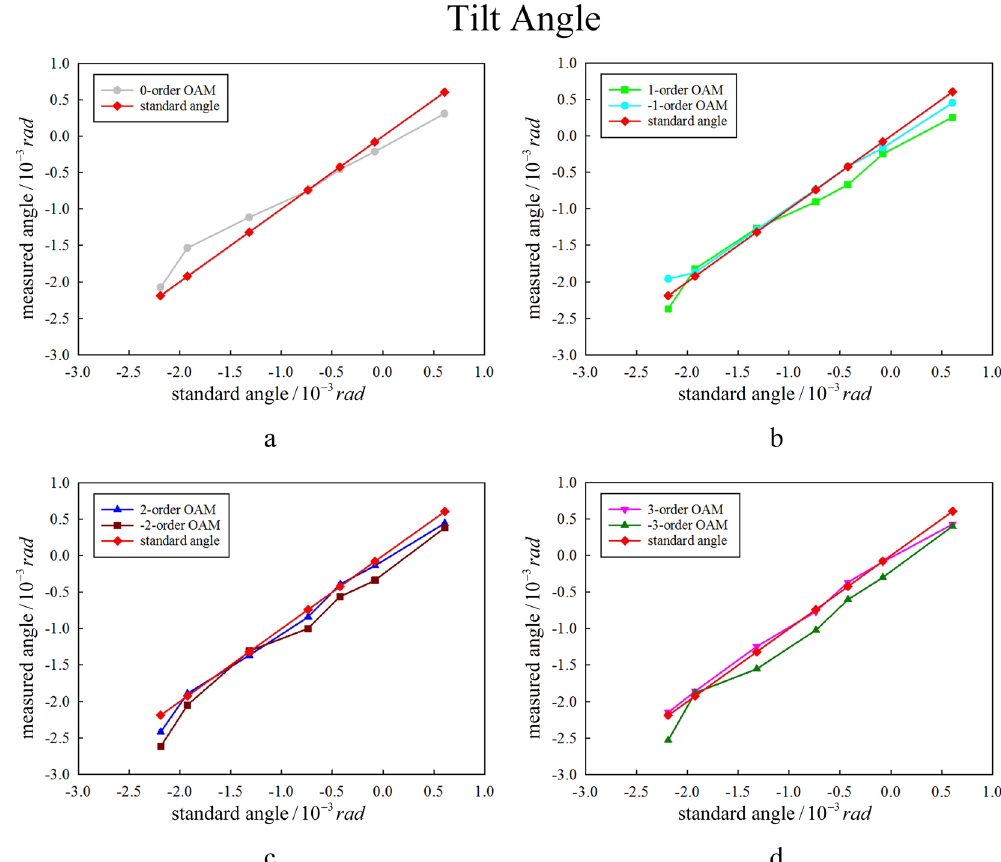
Figure 6. The measured tilt angle, with beams carrying OAM of l = − 3~3. The horizontal coordinate denotes the standard tilt angles obtained by the pattern shifts of the interference of two Gaussian beams while the standard tilt angle is plotted as a red diamond line with slope of 1. ( a ) l = 0. ( b ) l = − 1 and 1. ( c ) l = − 2 and 2. ( d ) l = − 3 and